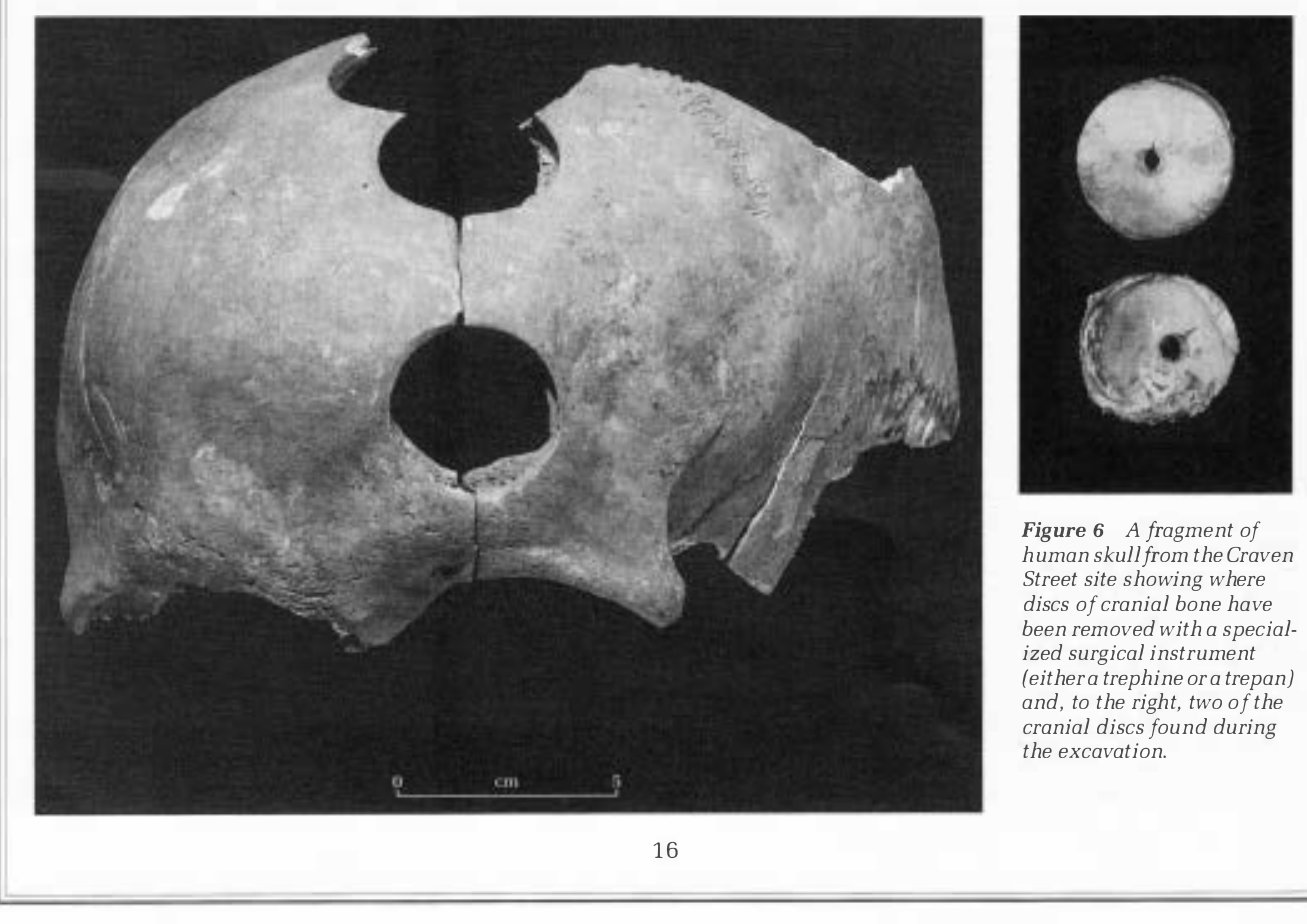
A fragment of human skull from the Craven Street site showing where discs of cranial bone have been removed with a special­ ized surgical instrument (either a trephine ora trepan) and, to the right, two of the cranial discs found during the